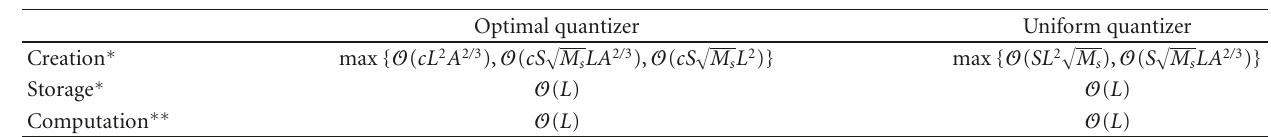
Optimal quantizer Uniform